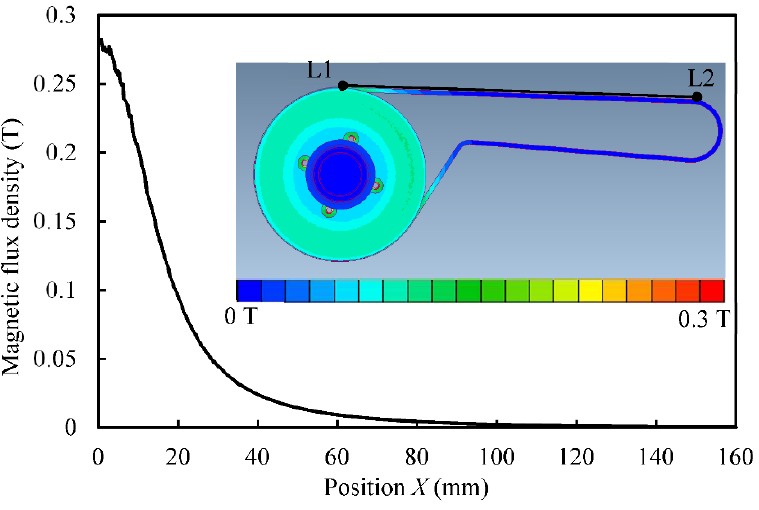
Figure 4. Magnetic field distribution in the direction of conveyor belt movement.